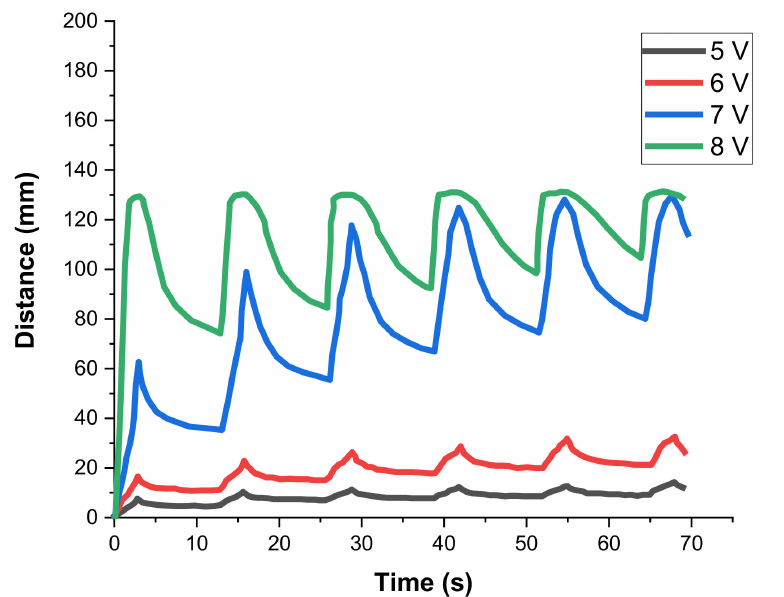
Figure 7. Bending distance of the adaptive structure at different voltages over the measurement